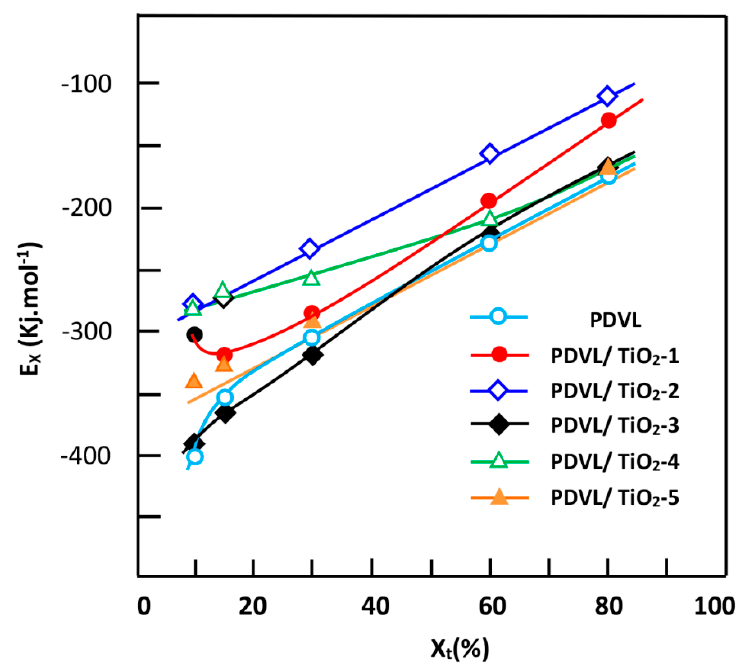
Figure 13. Curves indicating the variation of the effective energy barrier E x vs. the relative crystallization X t for the pure PDVL and PDVL/TiO 2 hybrid materials containing different TiO 2 contents.